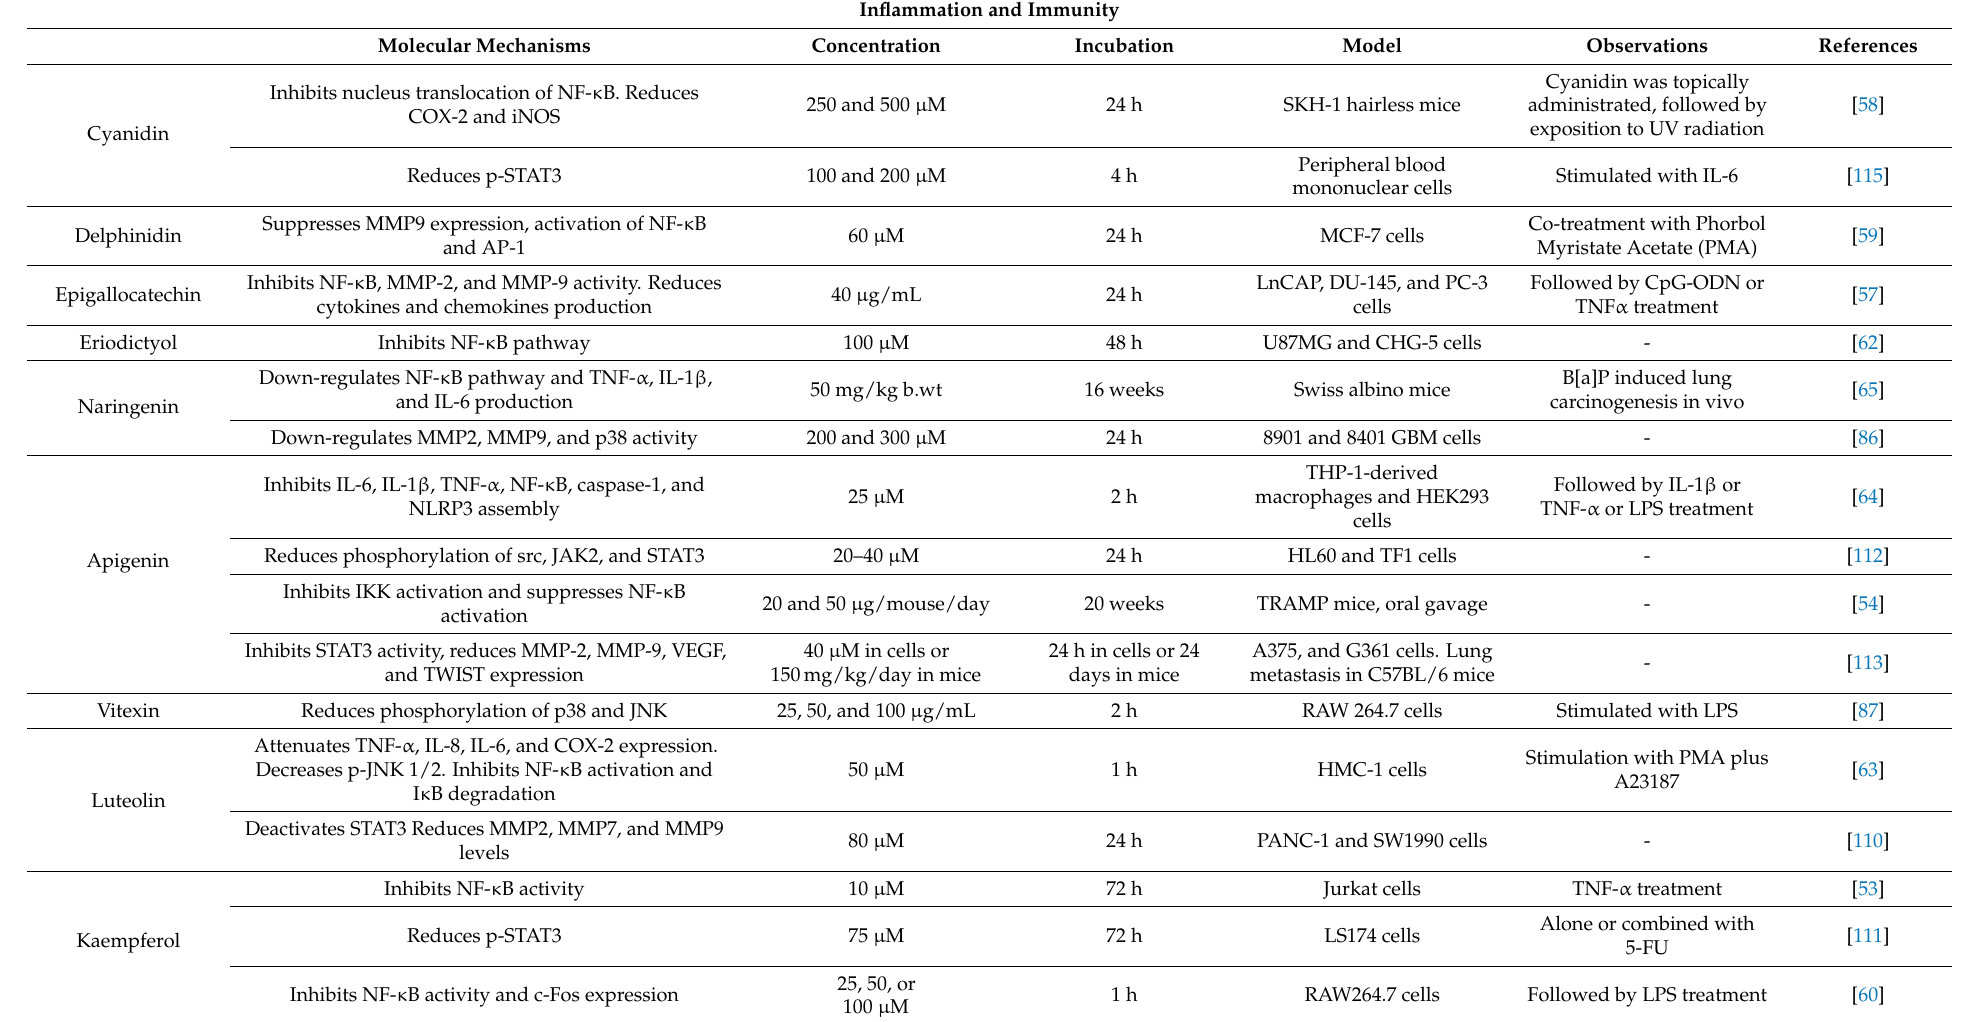
Table 3. Molecular mechanisms of flavonoids in inflammation, immunity, and